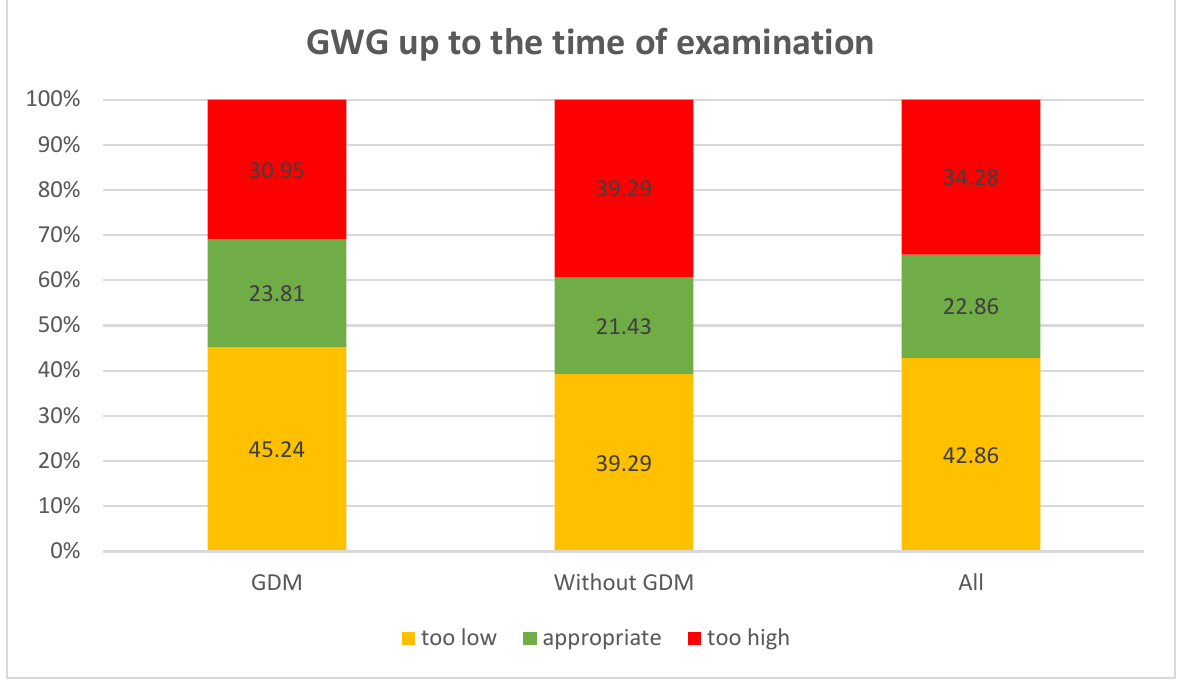
Figure 1. Gestational weight gain up to the time of examination.